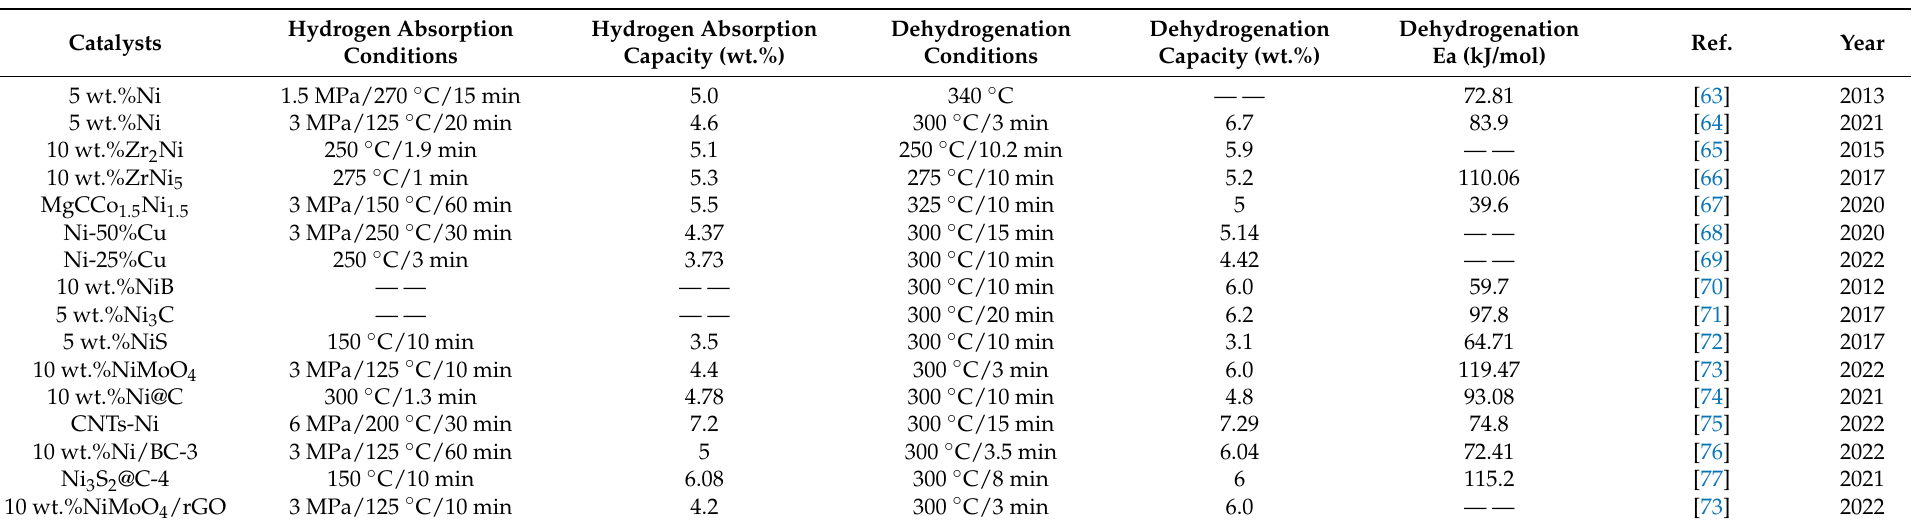
Table 3. Hydrogen storage performance of Mg/MgH 2 system doped with nickel-based